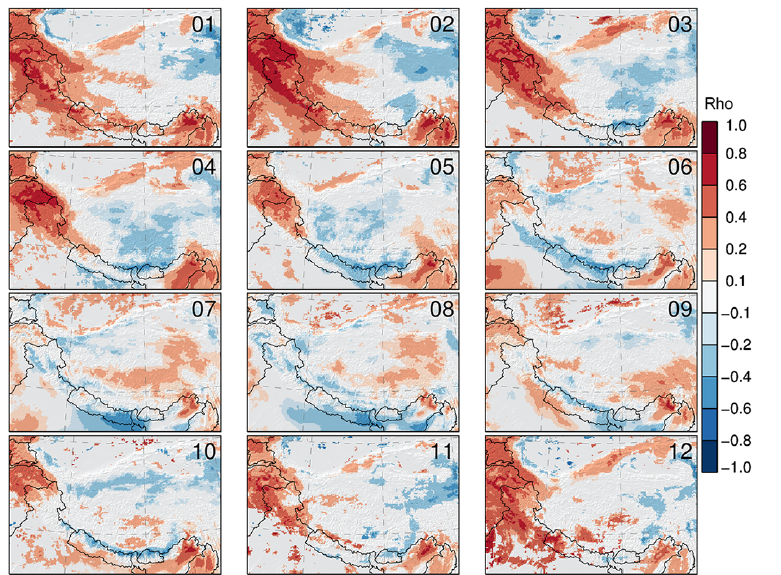
Figure 4. Coefficient of correlation (rho) between horizontal wind speed at model level 10 (WS10) and precipitation for all months (1–12). Positive correlations are denoted in red, while negative correlations are denoted in blue.